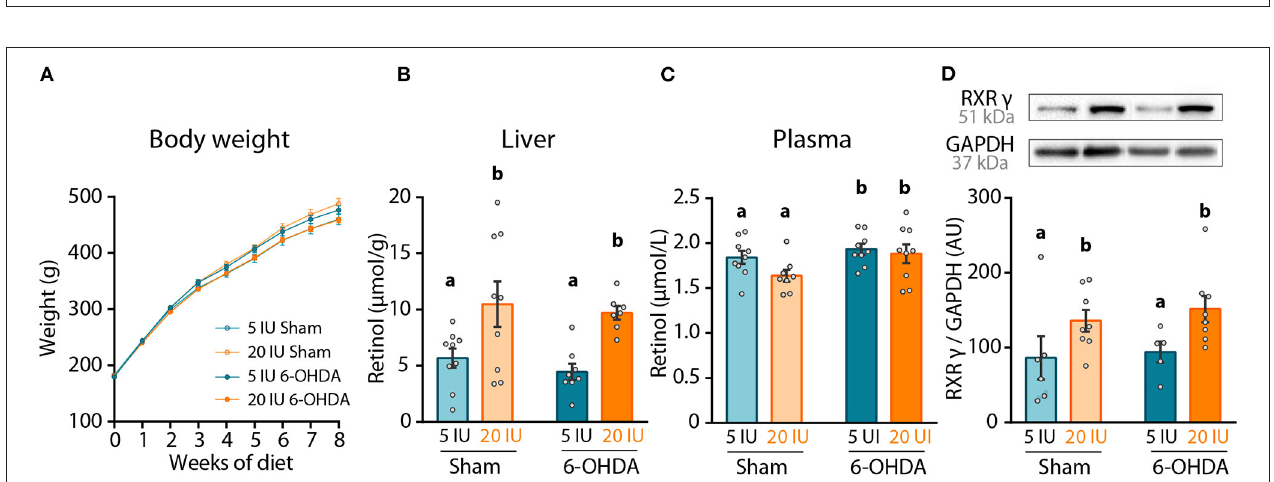
FIGURE 2 | Impact of dietary vitamin A and 6-OHDA injection on retinol levels and striatum RXR γ expression. (A) Measure of rats’ body weight (g) throughout experiment. (B,C) Levels of retinol in the liver ( µ mol/g) (B) , and in the plasma ( µ mol/L) (C) . (D) Representative western blot for retinoid X receptor gamma (RXR γ ) in striatum homogenates (upper inset) and quantification (graph). Protein expression levels were normalized with GAPDH for each sample. Results are expressed as means ± SEM, with individual data points for histograms. a, b: values significantly different ( p < 0.005). Details of the statistical analysis are summarized in Table 3 .